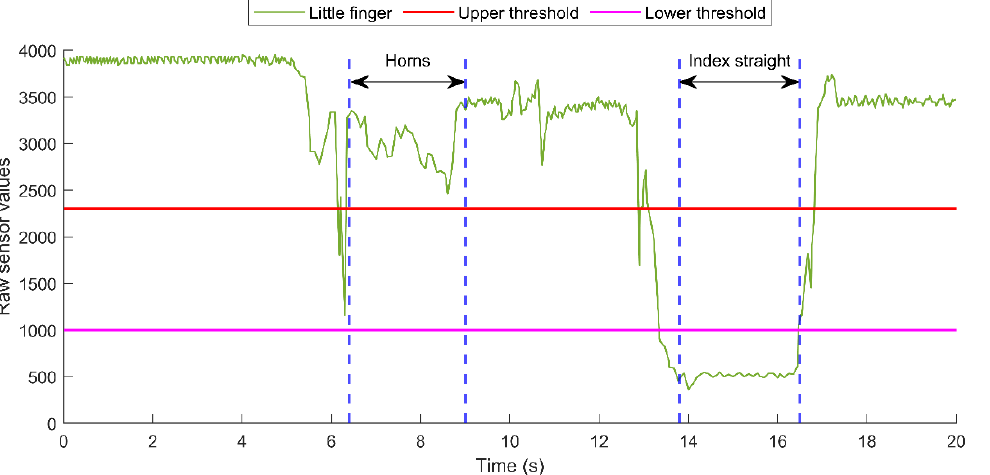
Figure 4. Sensor values of the little finger when Horns (index and little finger straight) and Index straight gestures were made within the time frame. As the little finger is straight in Horns , the sensor value is high, whereas in Index straight the little finger is bent, and the sensor value is low. There are two example gestures made in the sequence of 20 s, Horns (the index and little finger is straight, the rest are bent) and Index straight (only the index finger is straight, the rest are bent), and the fingers are held straight otherwise. Such gestures lead the little finger to be straight during the Horns gesture and bent with the Index straight gesture. The sensor value for the little finger is presented in a green color and the time sequences where the gestures were recognized are illustrated with blue dashed lines. Each finger has three bending states, 0 when the sensor value is more than the red-colored upper threshold, 1 when the sensor value is between the thresholds, and 2 when the sensor value is less than the magenta-colored lower threshold.